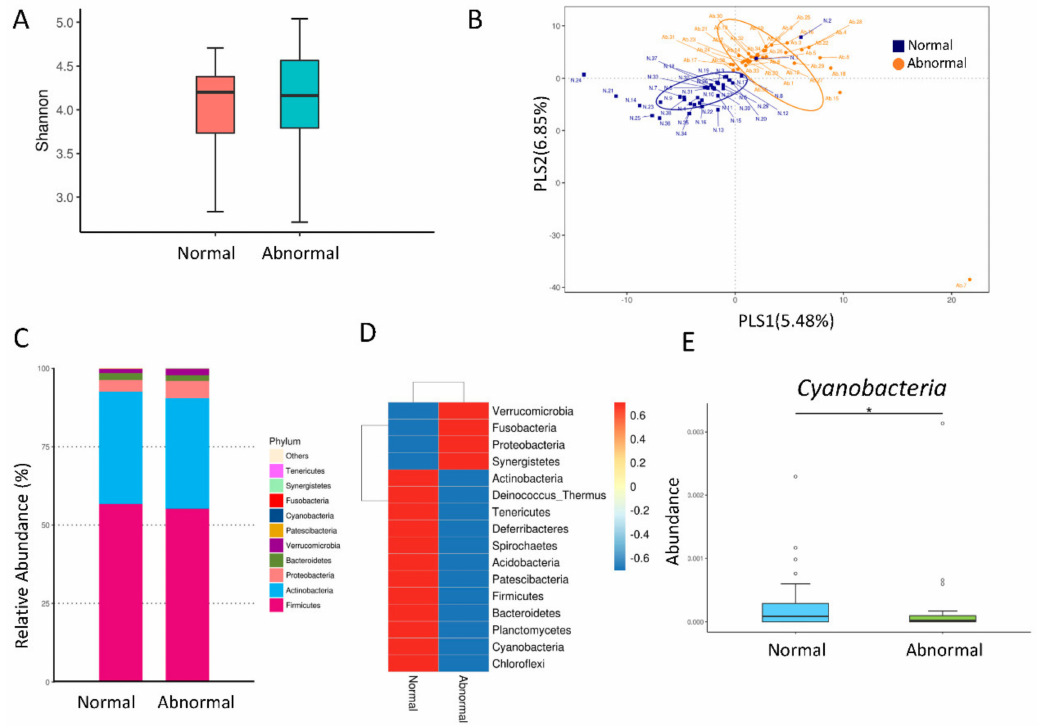
Figure 2. ( A ) Fecal bacterial α -diversity in CKD children with normal and abnormal ABPM represented by the Shannon’s diversity indexes. ( B ) β -diversity changes in gut microbiota between CKD children with normal and abnormal ABPM by the partial least squares discriminant analysis (PLS-DA). ( C ) Relative abundance of top 10 phyla of the gut microbiota between the normal and abnormal ABPM group. ( D ) Heat map of 16S rRNA gene sequencing analysis of gut microbiome at the phylum level. ( E ) The abundance of phylum Cyanobacteria in CKD children with normal vs. abnormal ABPM. The asterisk indicates p <